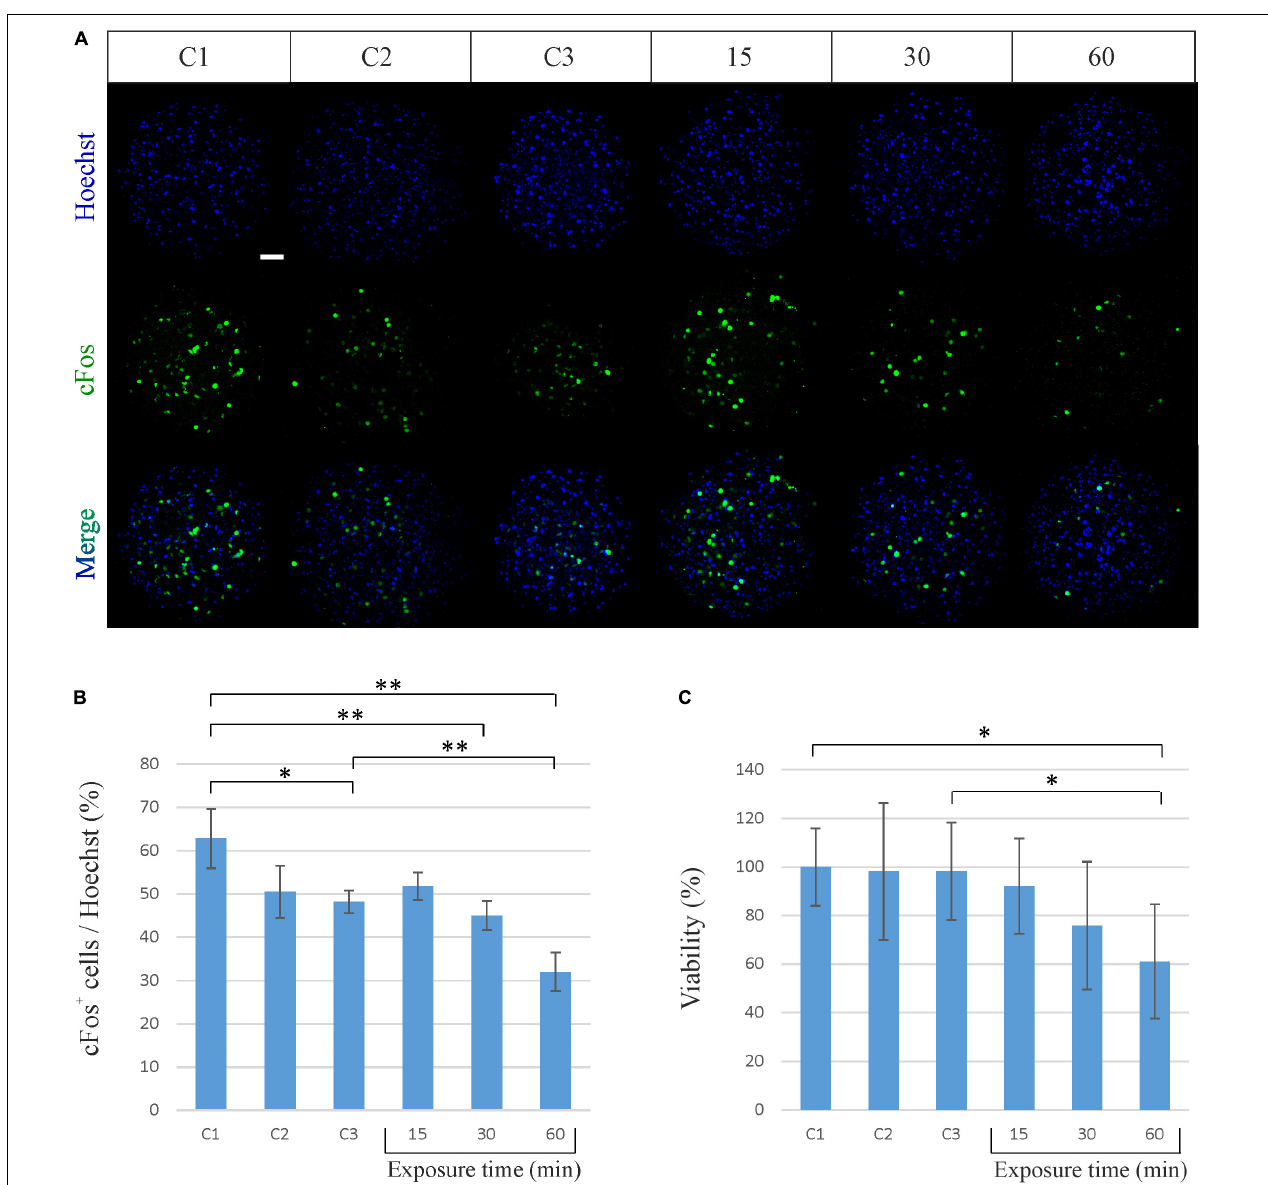
FIGURE 3 | Biological effects of sinusoidal RF EM field (2–6 GHz) on neuronal spheroids activity and viability. (A) Representative confocal immunofluorescence images of neuronal spheroids used as controls (C1, C2, C3) and spheroids exposed to the EM field for 15, 30, and 60 min. Spheroids were stained against cFos (green) and all cell nuclei (Heachst, blue). Scale bar: 50 µ m. (B) Quantitative analysis showing the percentage of cFos-positive (cFos + ) cells out of the total cells (Heachst). The graph shows the mean ± SD, n = 4–6 per group. ∗ P < 0.05; ∗∗ P < 0.01. (C) Percentage of viable neuronal cells after exposure to the EM field for 15, 30, and 60 min. The graph shows the mean ± SD of three experiments performed separately with eight spheroids per group per experiment. ∗ P < 0.05. C1, control spheroids, always kept in the incubator; C2, control spheroids, kept outside the incubator for 30 min; C3, control spheroids, kept outside the incubator for 60